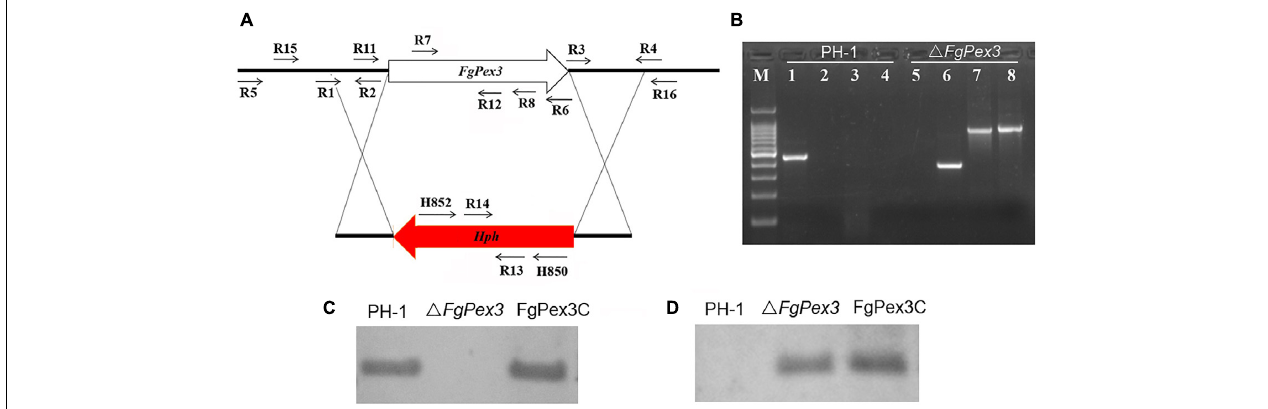
FIGURE 2 | The FgPex3 gene replacement construct. (A) Schematic representation gene disruption strategy. FgPex3 is denoted by an open arrow; hygromycin resistance cassette ( hph ) is represented by a red arrow. The annealing sites of primers are indicated by small black arrows. (B) PCR analysis of PH-1 and FgPex3 deletion mutant using primers R7/R8, H850/H852, H852/R16, and R15/H850, respectively. 1–4: PCR products amplified with the above primers using PH-1 as template; 5–8: PCR products amplified with the above primers using (cid:49) FgPex3 as template. (C,D) Southern blot hybridization analyses of transformants with hybridization probe R11/R12 ( FgPex3 ) and R13/R14 ( hph ).